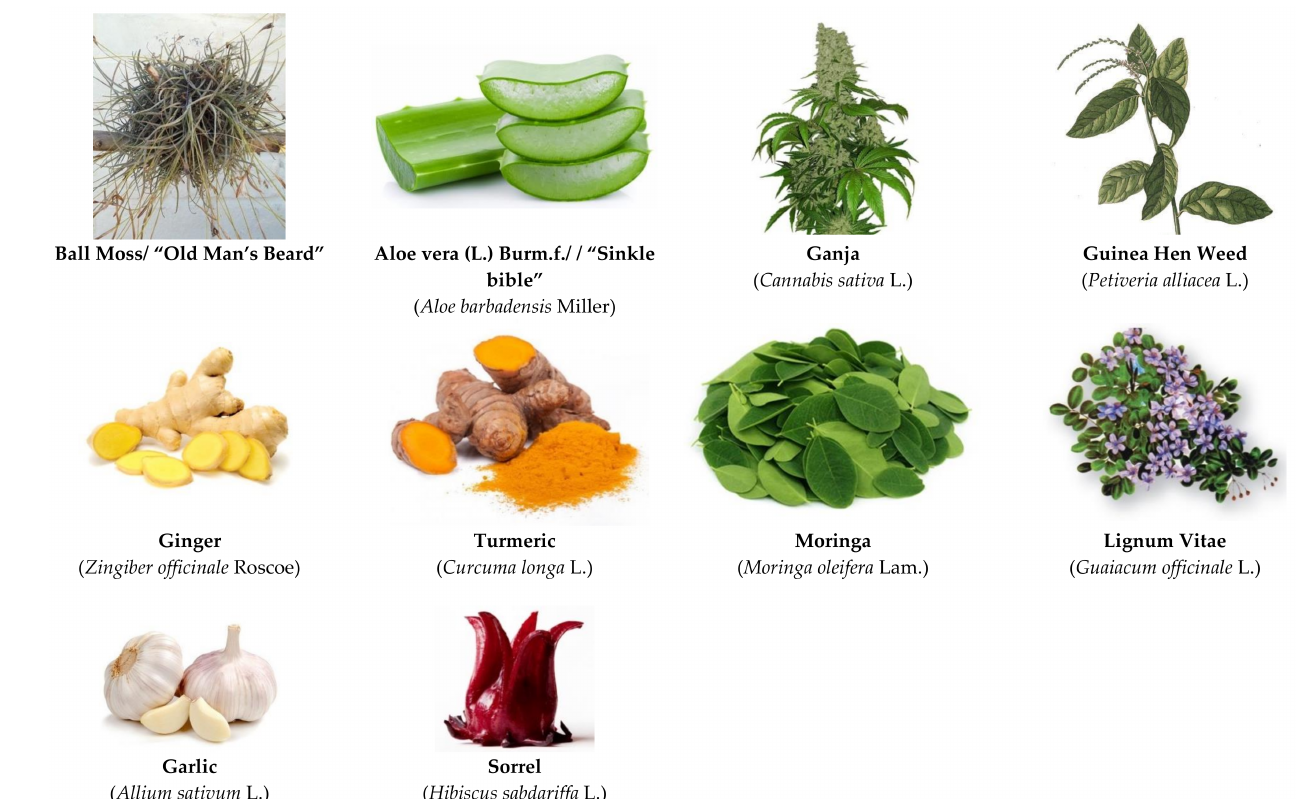
Figure 1. Some Jamaican plants with major antiviral